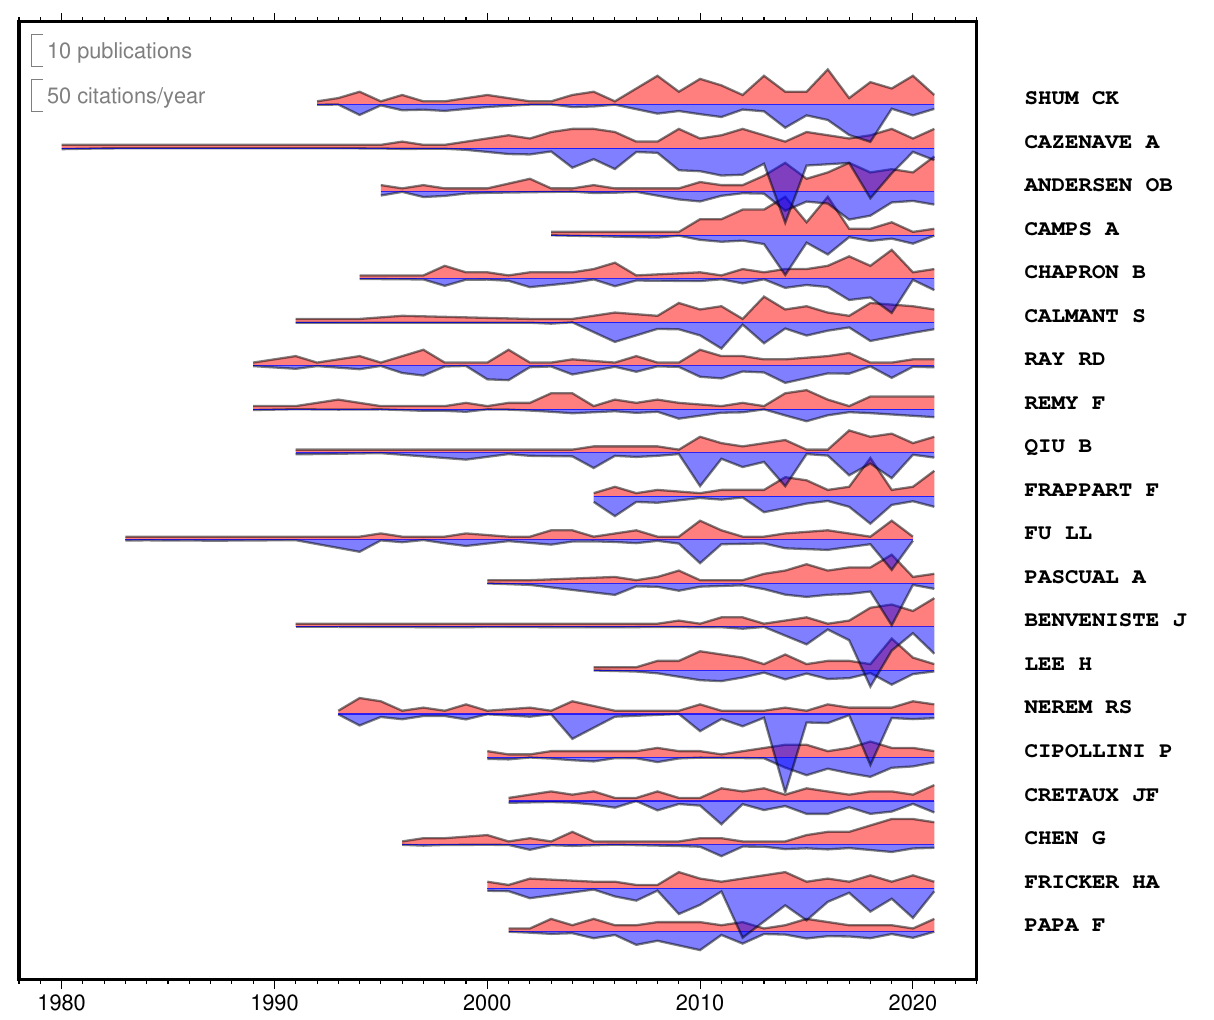
Figure 7. Authors’ production in terms of number of documents (red) and total citations (blue) per year of the document published in that